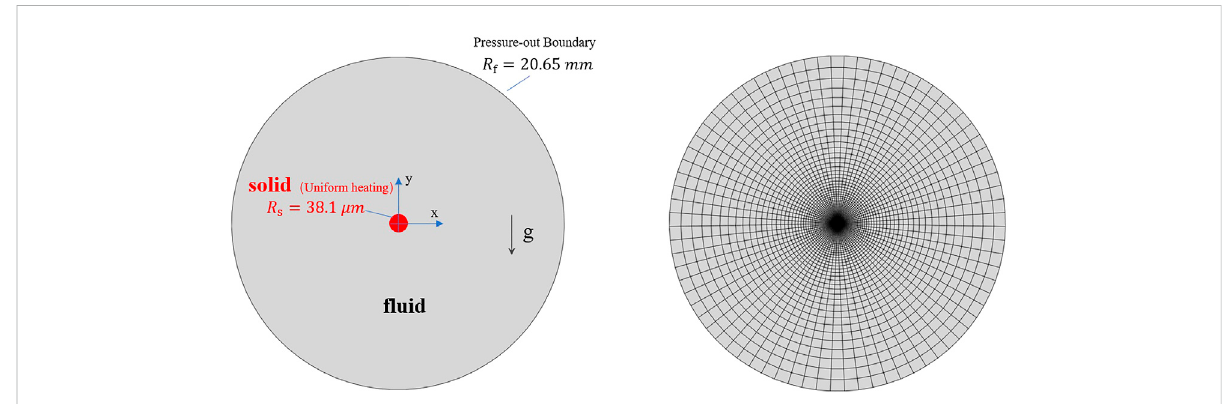
FIGURE 6 Computational domain and boundary conditions in supercritical